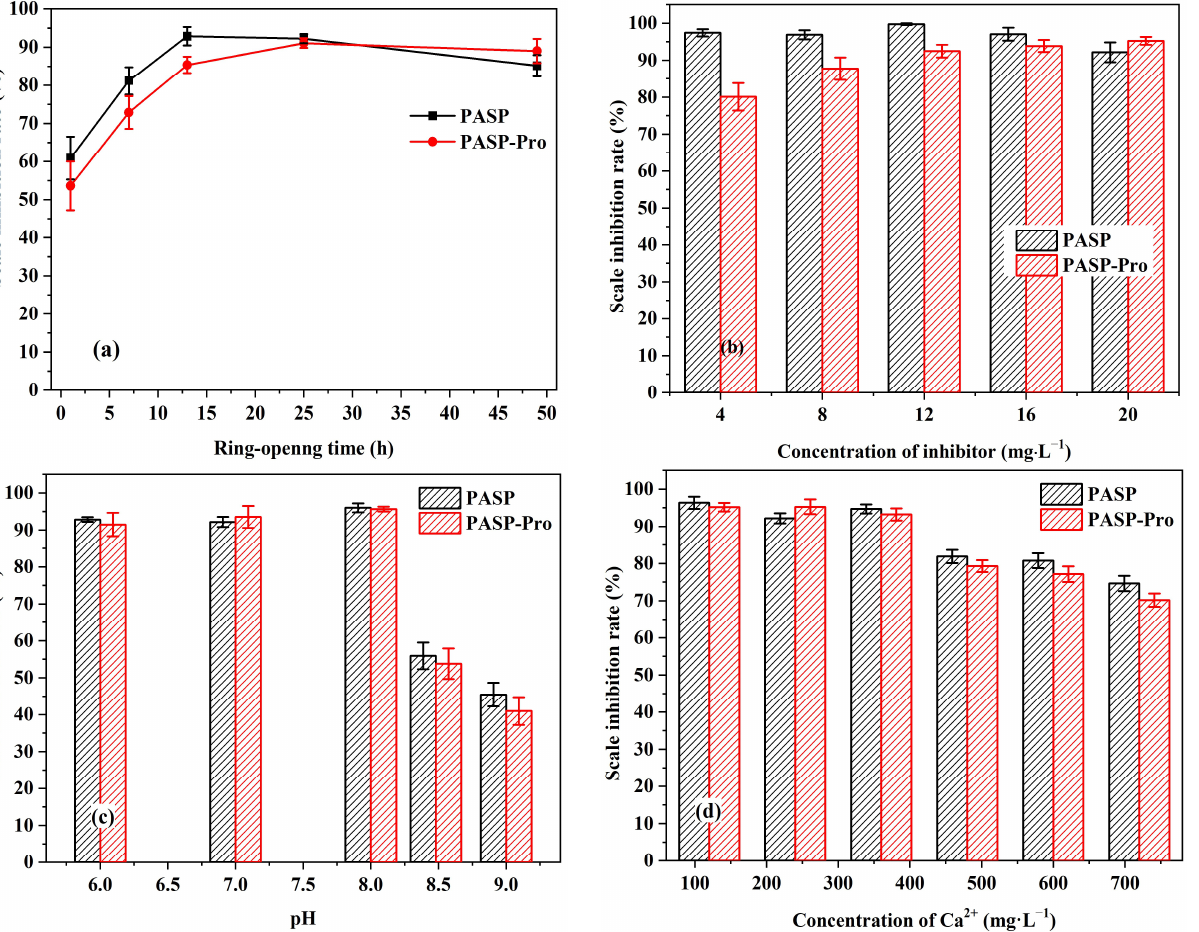
Figure 5. The effects of ring-opening time ( a ); concentration of inhibitors ( b ); pH ( c ); and concentration of Ca 2+ ( d ) on scale inhibition rate. Static experiment details: ring-opening time of the inhibitors is 25 h, ρ (Ca 2+ ) = 240 mg/L and ρ (HCO 3 − ) = 732 mg/L in artificial solution, pH = 7, the concentration of the inhibitors is 20 mg/L, bath temperature is 80 °C, and bath time is 10 h, except for the variables in each experiment.